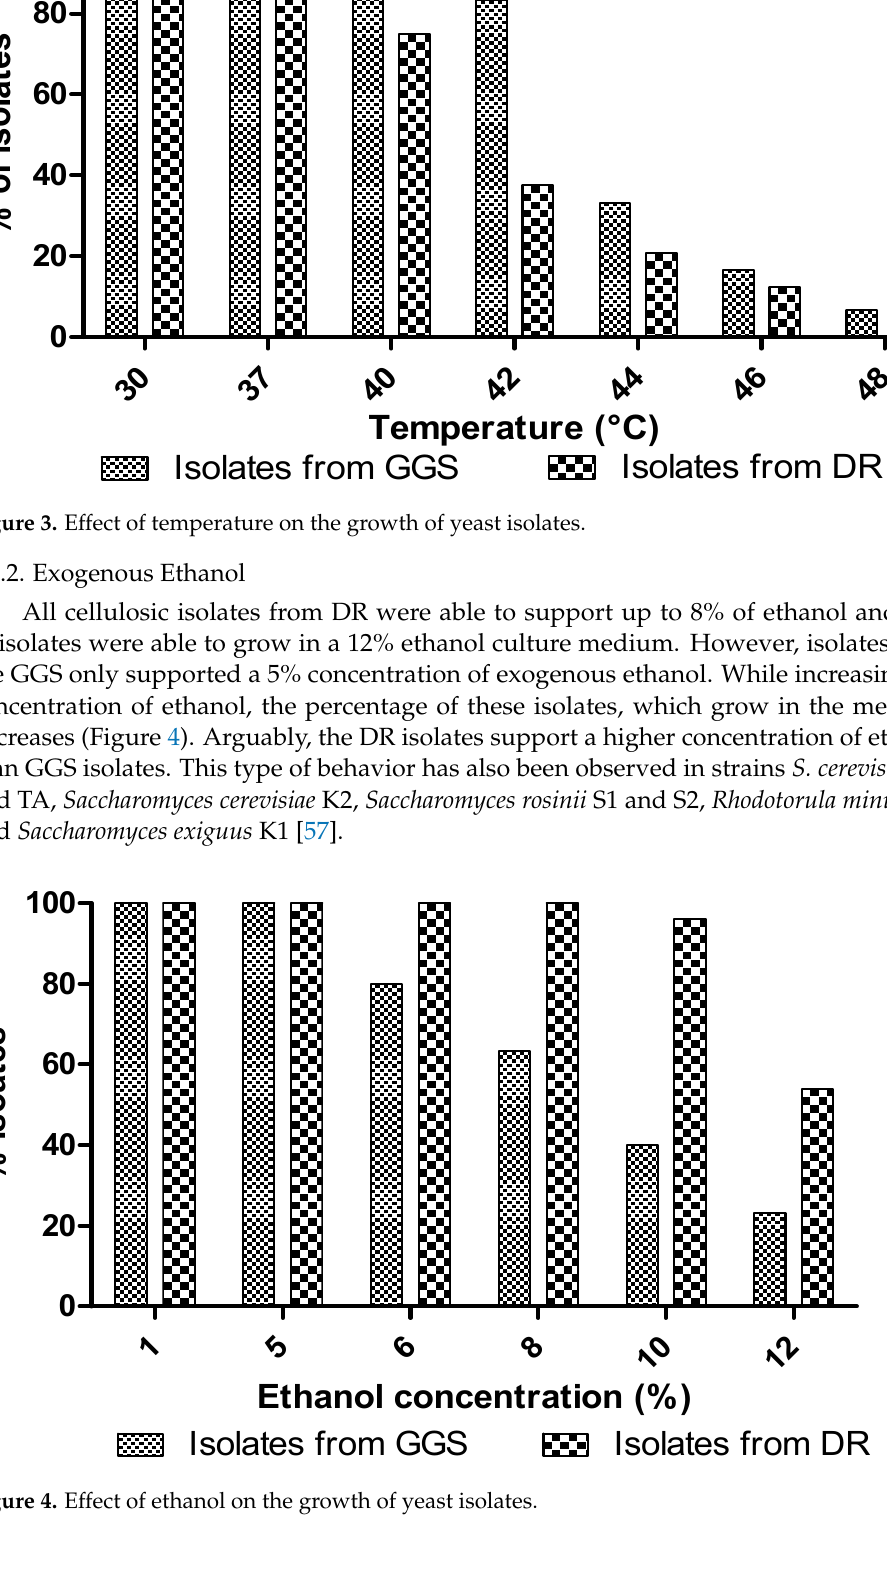
Figure 4. Effect of ethanol on the growth of yeast isolates.